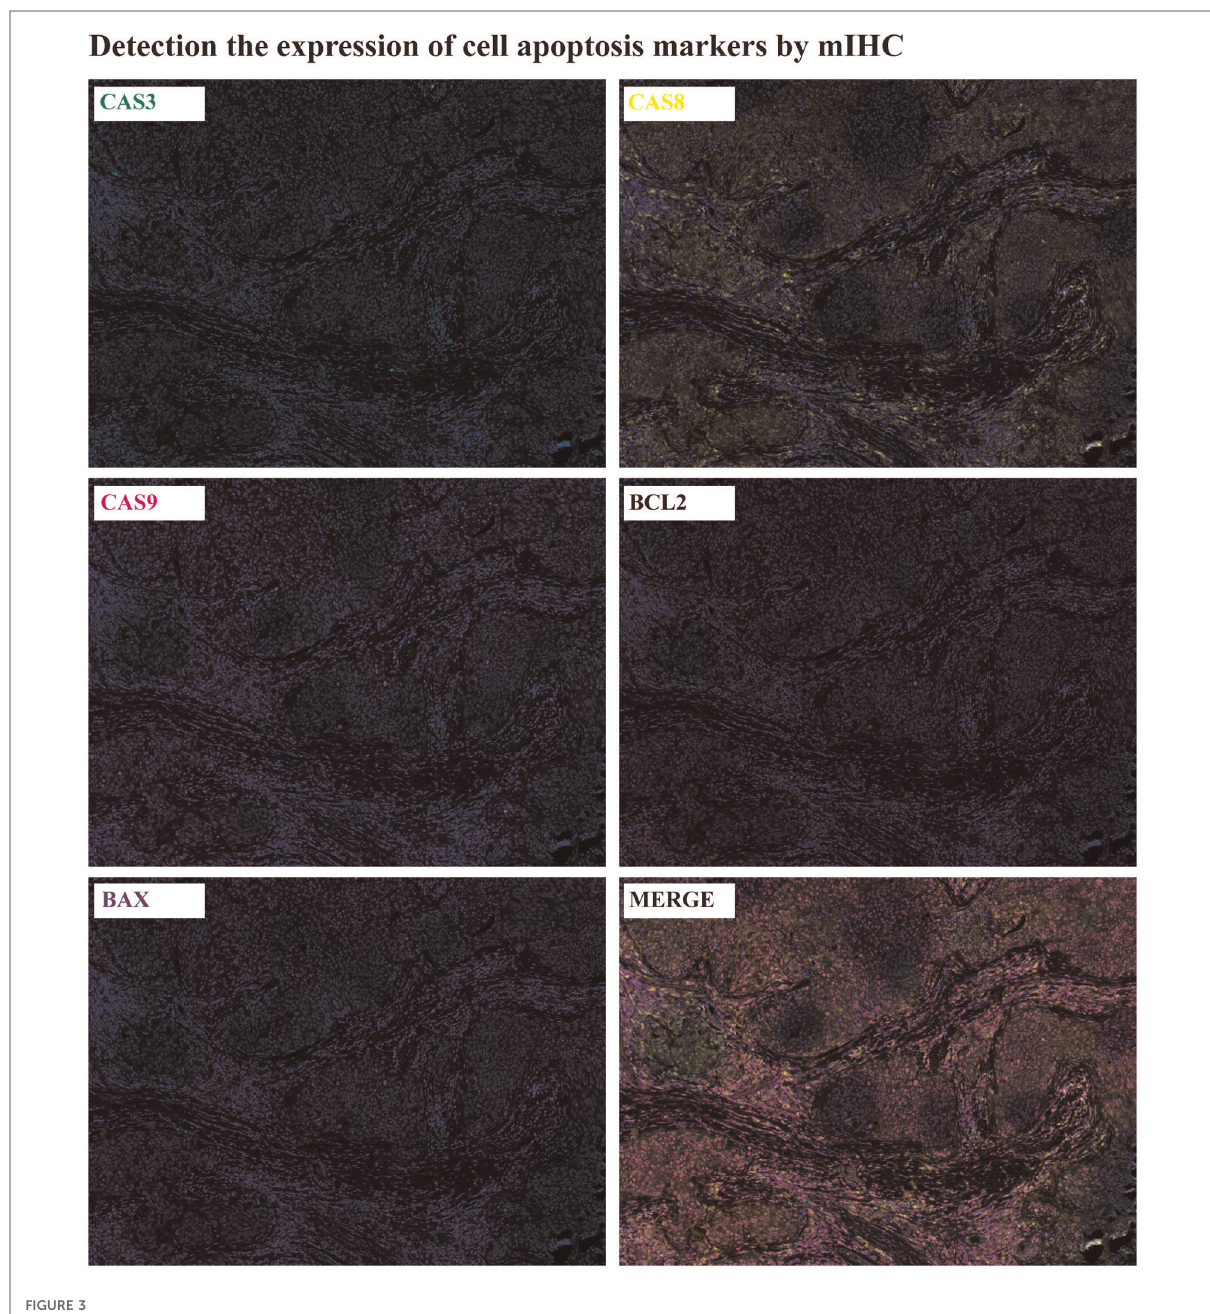
FIGURE 3 Detection the cell apoptosis by